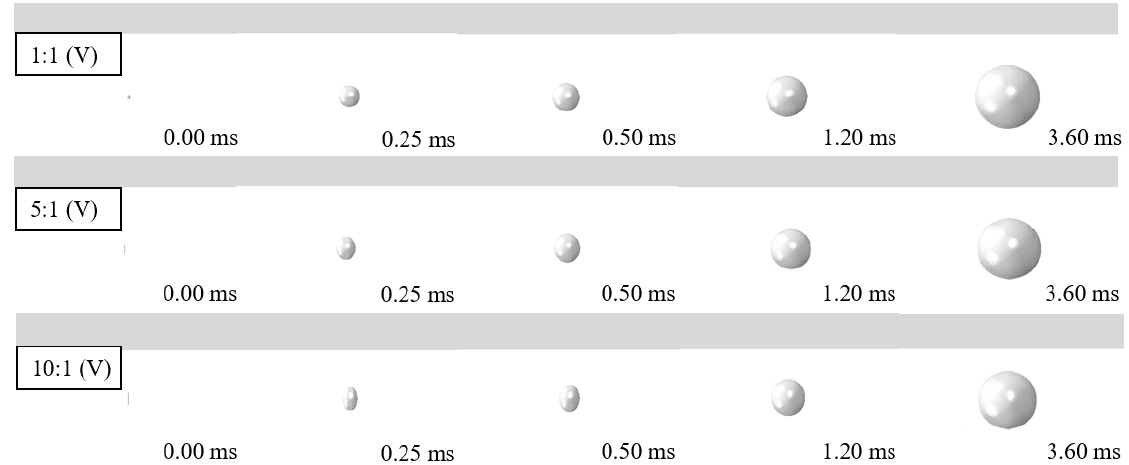
Figure 22. Comparison of the bubble development for various shapes of the charge.